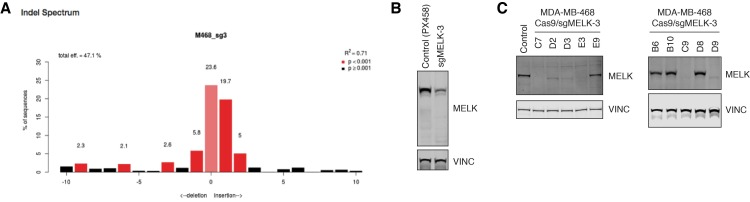
CRISPR/Cas9-mediated knockout of MELK in MDA-MB-468 cells.(A) Tracking of Indels by Decomposition (TIDE) analysis (Brinkman et al., 2014) of MDA-MB-468 cells transfected with Cas9/sgMELK-3 and enriched by the transfection marker OFP. (B) Immunoblots for MELK and VINC in MDA-MB-468 cells transfected with PX458 or Cas9/sgMELK-3 and enriched by the transfection marker GFP or OFP, respectively. (C) Immunoblots for MELK and VINC in ten MDA-MB-468 clones selected from MDA-MB-468 cells transfected with Cas9/sgMELK-3. Clone E9 is the WT clone, and clone C7 is the MELK−/− clone shown in Figure 3. For the genotyping results, see also Figure 3—source data 1.